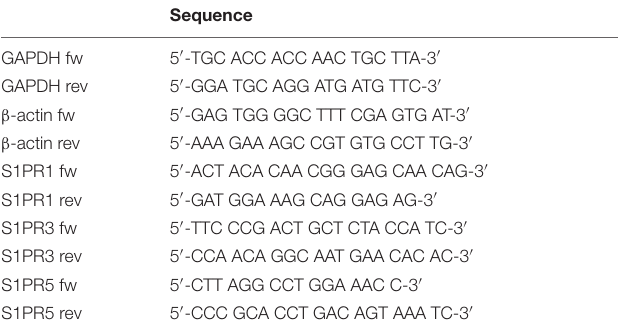
TABLE 1 | Primer sequences used for